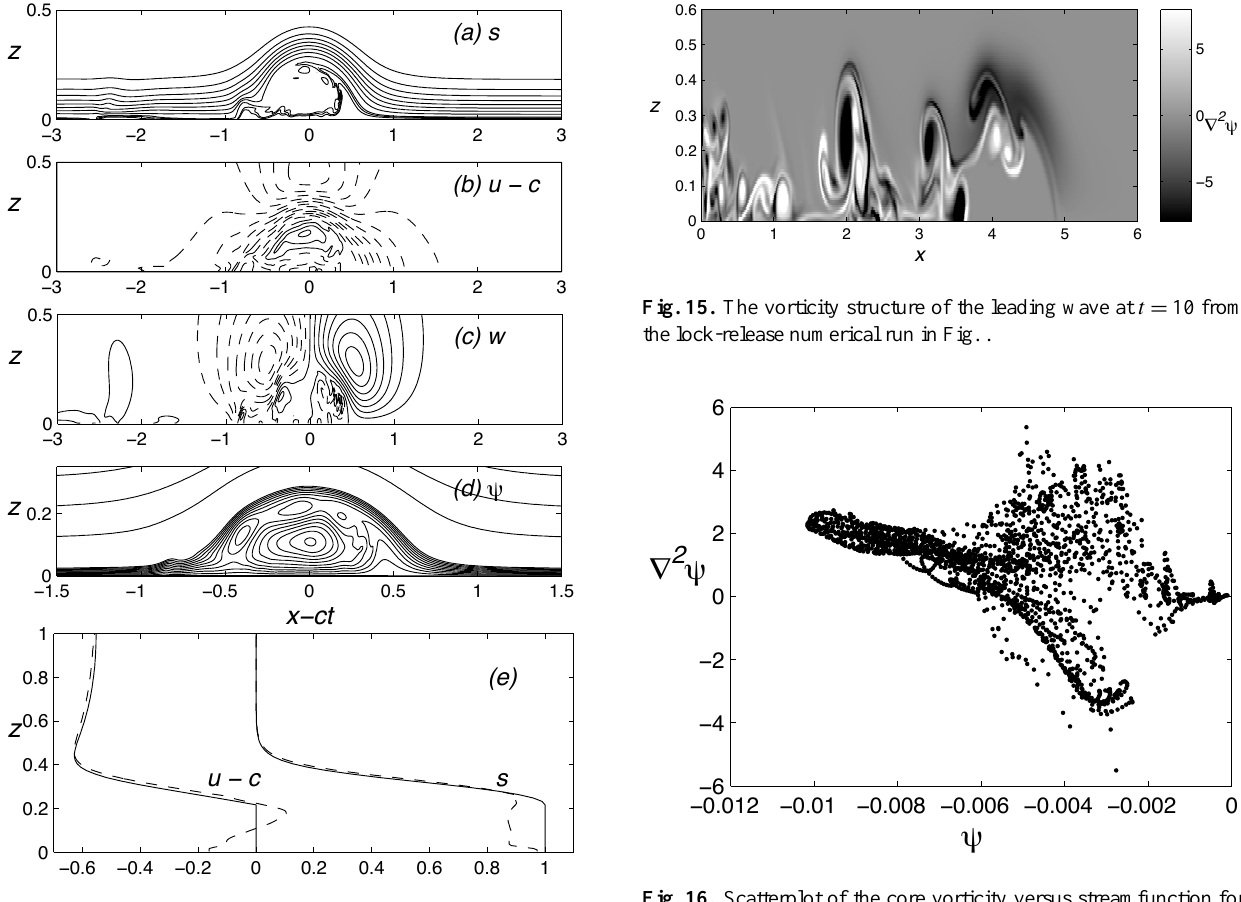
Fig. 14. The leading solitary wave from Fig. 13 at t = 300. (a) s , (b) u − c (c) w and (d) ψ . The wave travels at a constant speed c = 0 . 417 for t > 100. The s contour interval is 0.1 for s ≤ 0 . 9 and 0.025 for s > 0 . 9. The contour interval is 0.05 in (b) and 0.02 in (c), with solid lines for values ≥ 0. The ψ contour intervals in (d) are 0 . 001 for ψ ≥ 0 . 01 and 0.04 otherwise. (e) Vertical profiles of u − c and s at x − ct = 0 from the theory (solid) and numerical model (dashed). Note that the horizontal and vertical scales in (d) differ from those in (a)-(c).